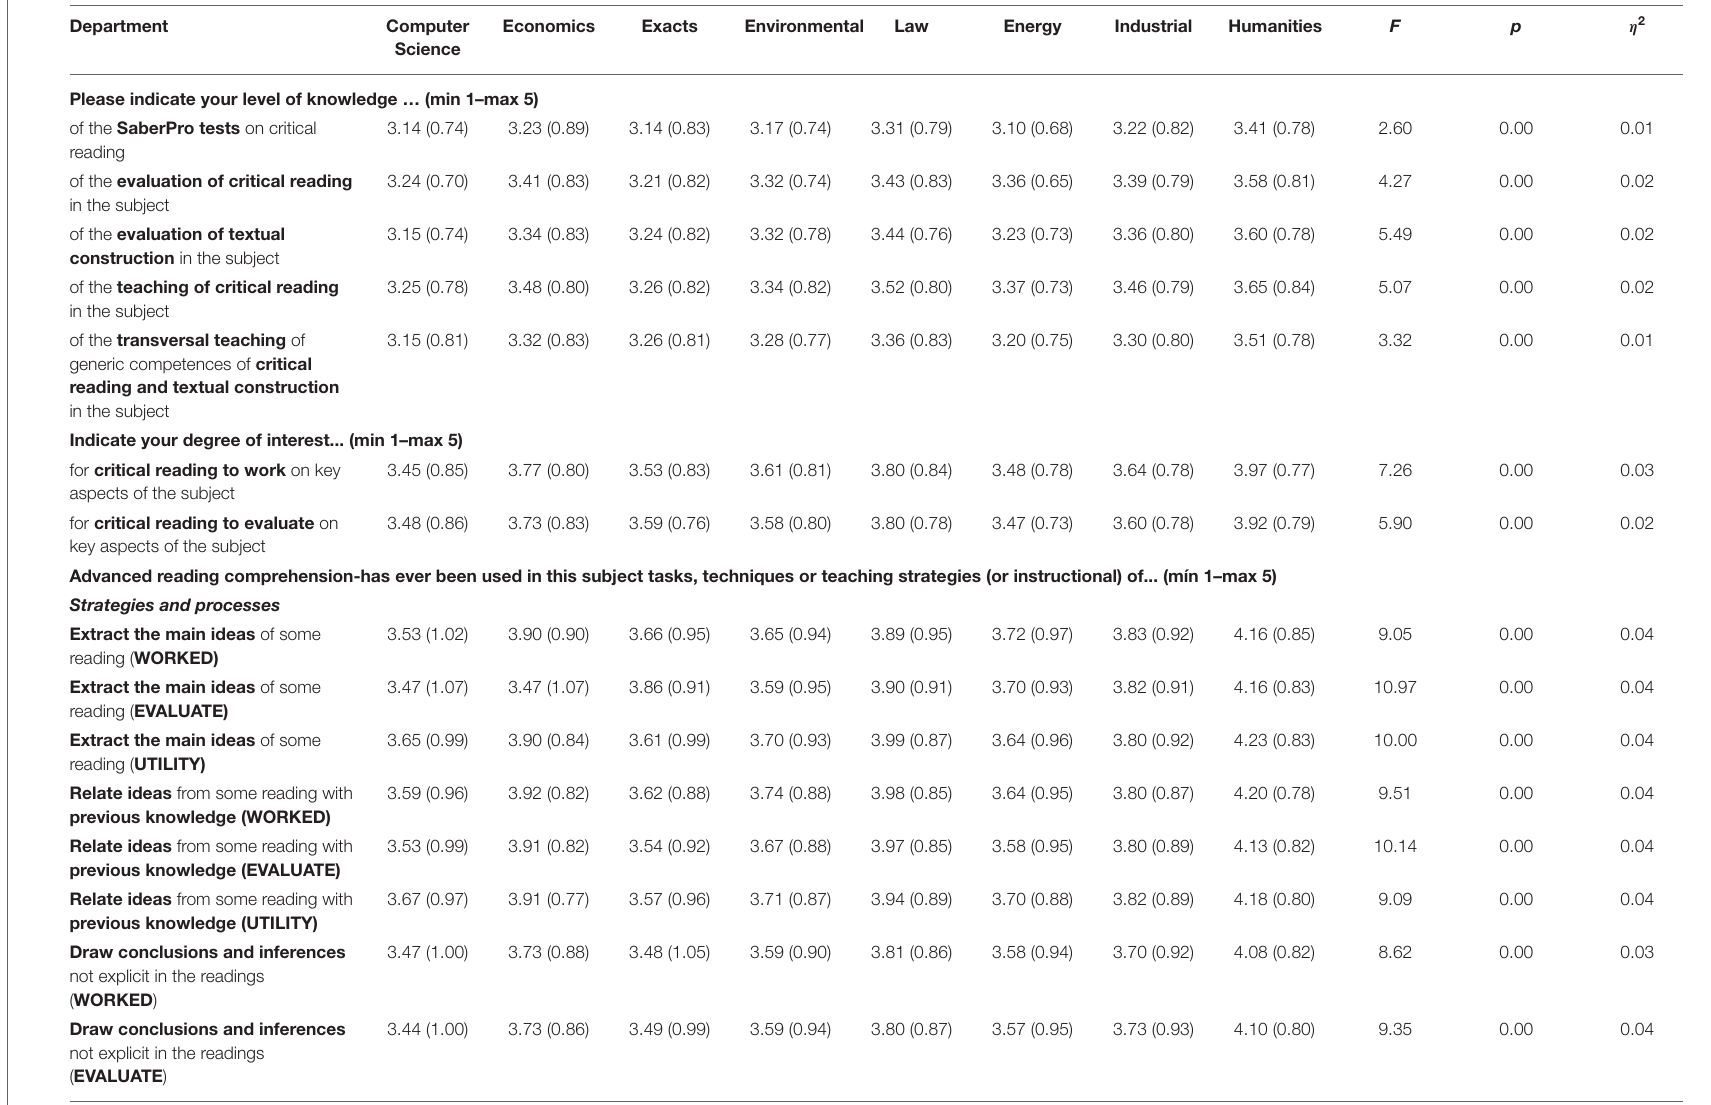
TABLE 3 | Tests of the inter-subject effects of the students in the instructional variables in ARC considering the department as a grouping variable.